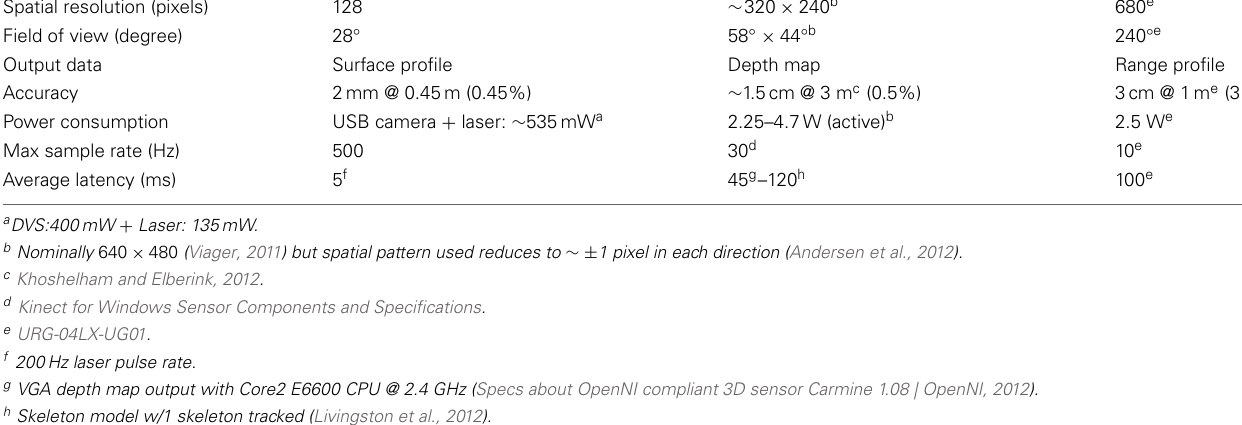
FIGURE 9 | The reconstructed surface. (A) CAD model of the surface. (B) This section of the reconstruction was chosen for display because in the Measured data points. (C) Interpolated reconstruction of the surface using surrounding area border effects were observed caused by the Gaussian Matlab’s TriScatteredInterp function. (D) Distance between closest profile of the laser line that reduced the DVS event rate to be too low to reconstruction point and model aligned using ICP (Besl and McKay, 1992). result in acceptable reconstruction. Table 2 | Performance comparison of the proposed approach with existing depth sensors. This work Microsoft Kinect for Xbox 360 LIDAR